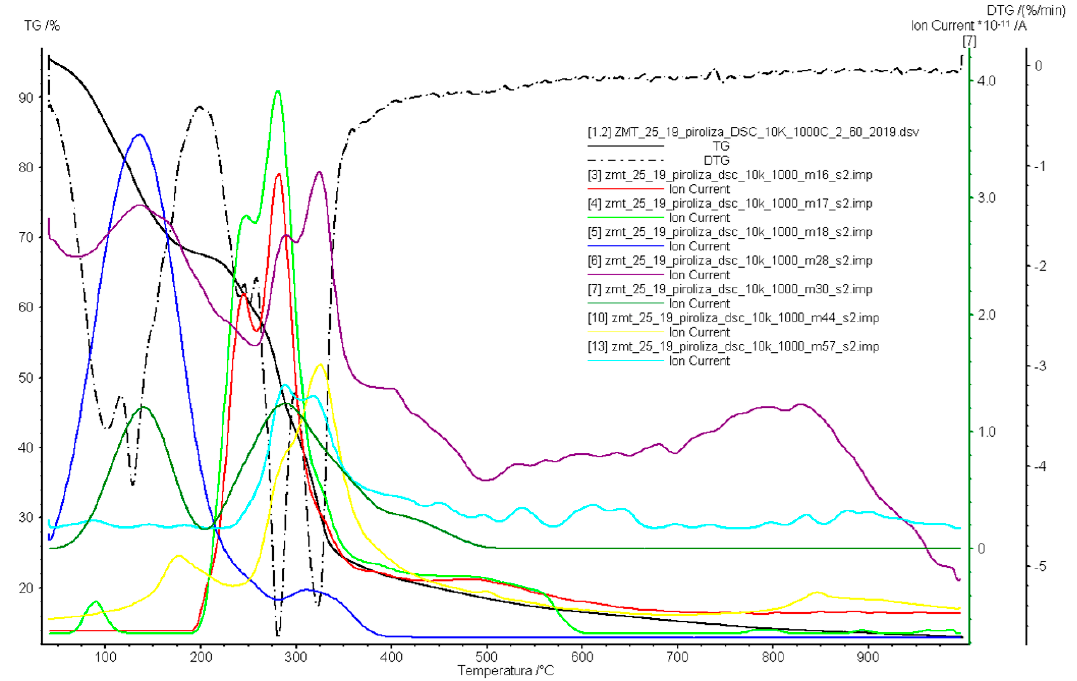
Figure 6. TG and DTG curves, and ion current intensity for the sample ZMT/25/2019 (own research).